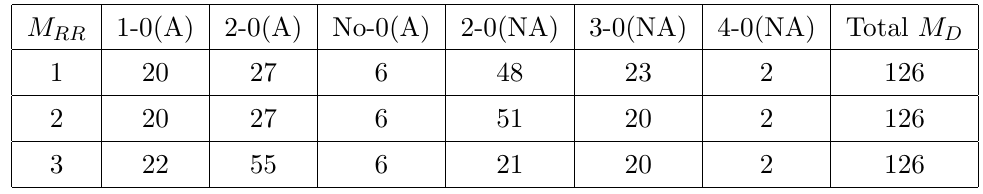
Table 2 . Number of di(cid:11)erent textures obtained for 5-0 M D , 4-0 M RR (with rank 3). A and NA in brackets represent allowed and not allowed